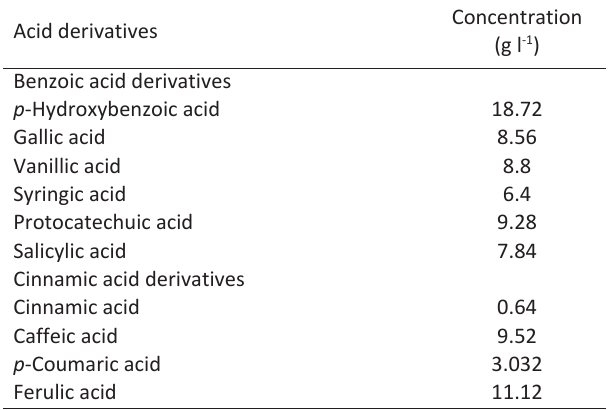
Table 3 - Phenolic acids in aqueous extract of celery at concen- tration 20 g l -1